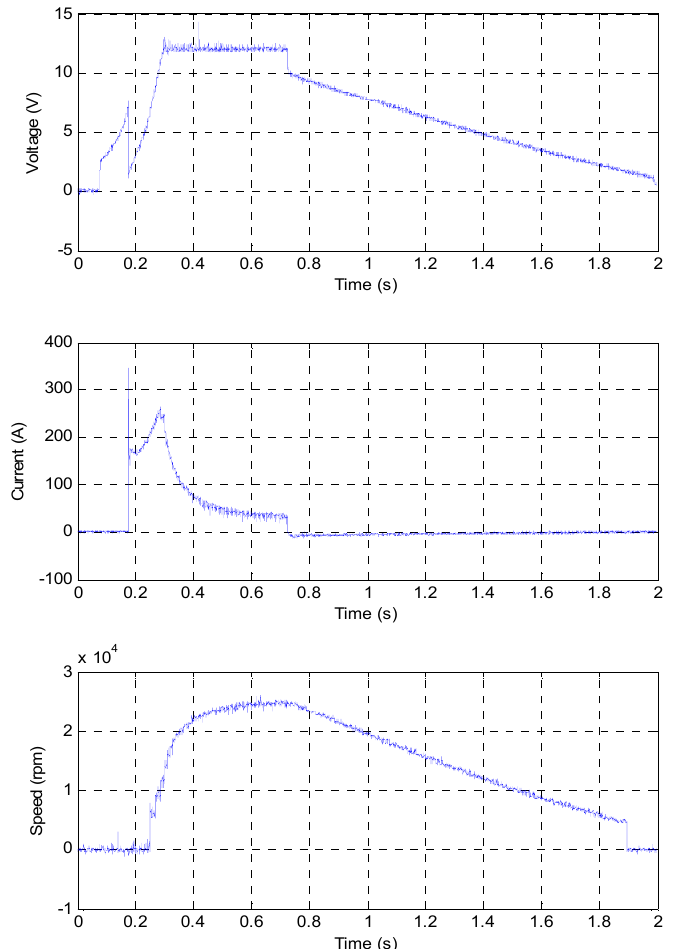
Figure 3. Starter motor test results.